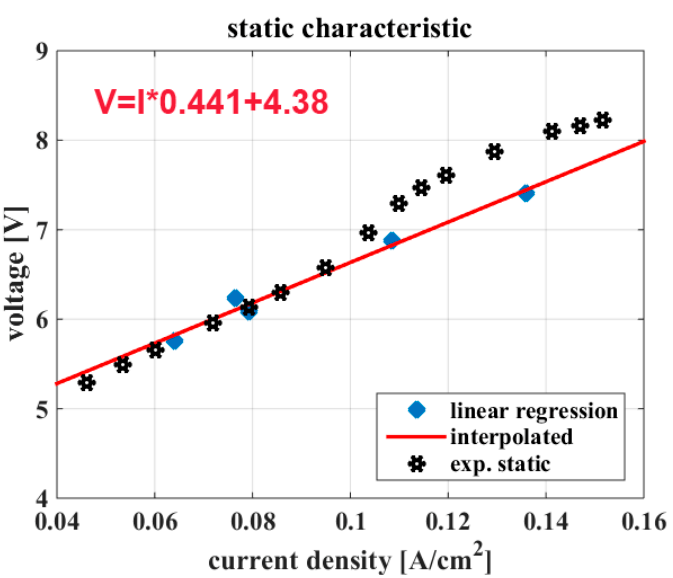
Figure 7. Static characteristic obtained by linear regression and experimental measurements.